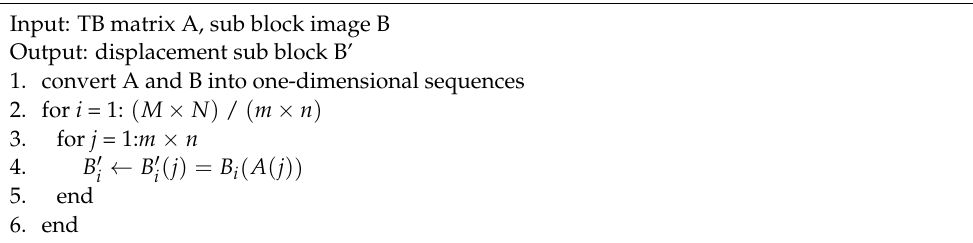
Algorithm 4 Pseudo code of built-in commutation in sub image block.